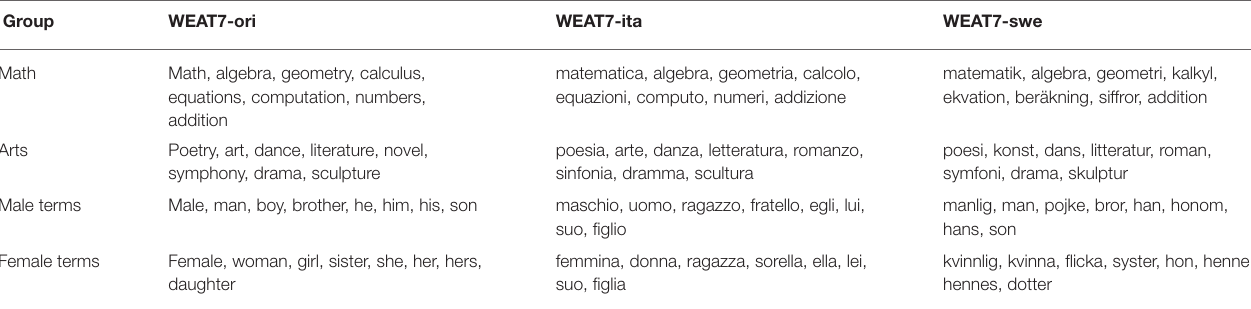
TABLE 4 | The terms from the original WEAT7 experiment (Caliskan et al., 2017) and our adaptations/translations to Italian and Swedish.